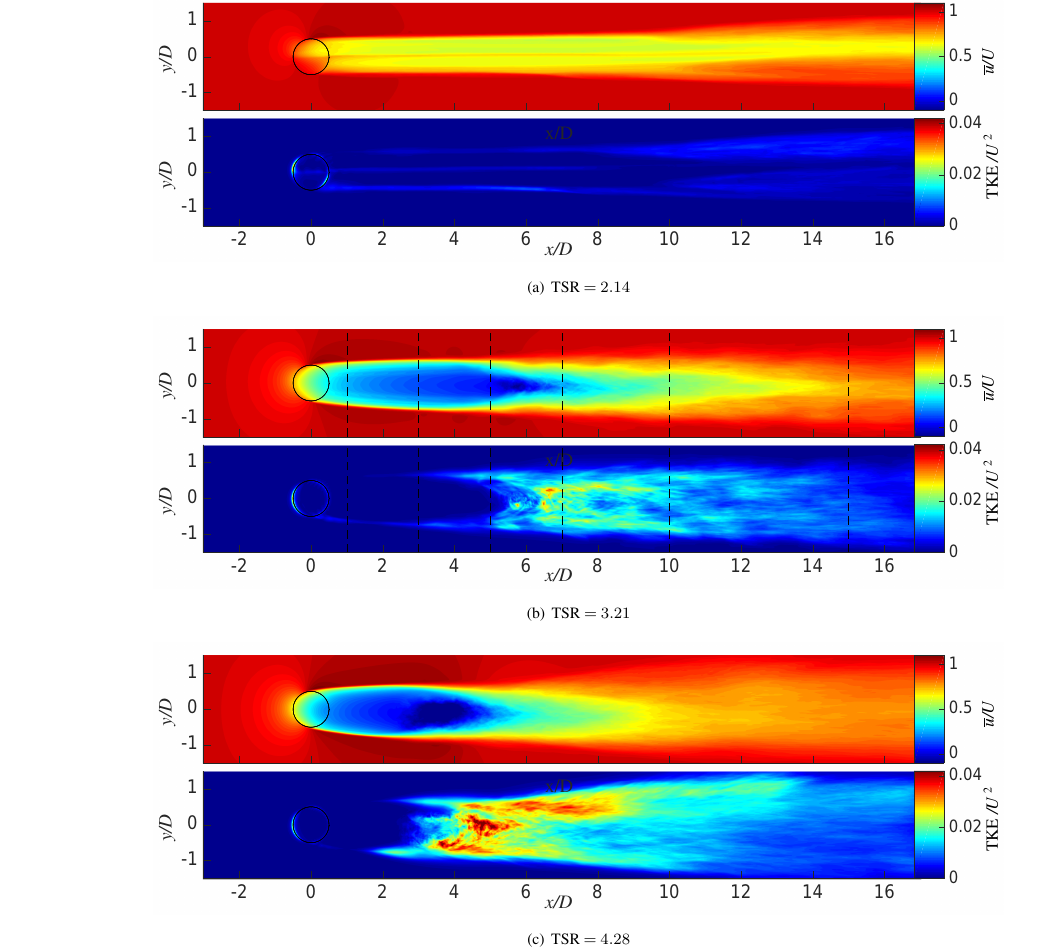
(cid:48) u (cid:48) + v (cid:48) v (cid:48) + w (cid:48) w (cid:48) in the 2 U 2 ∞